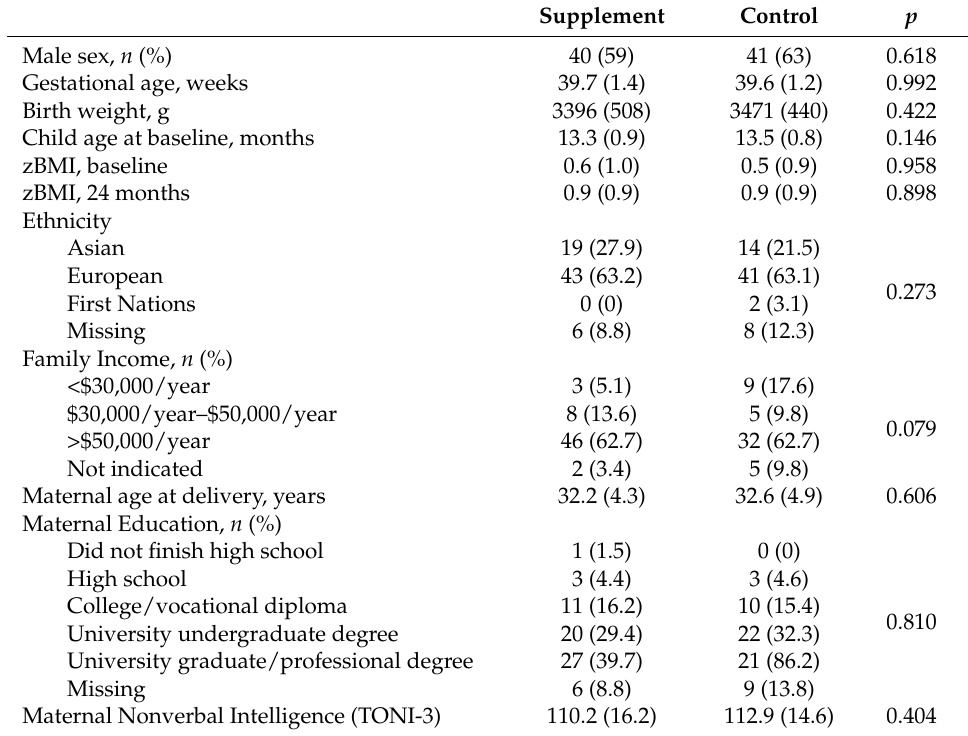
Table 2. Participant characteristics at